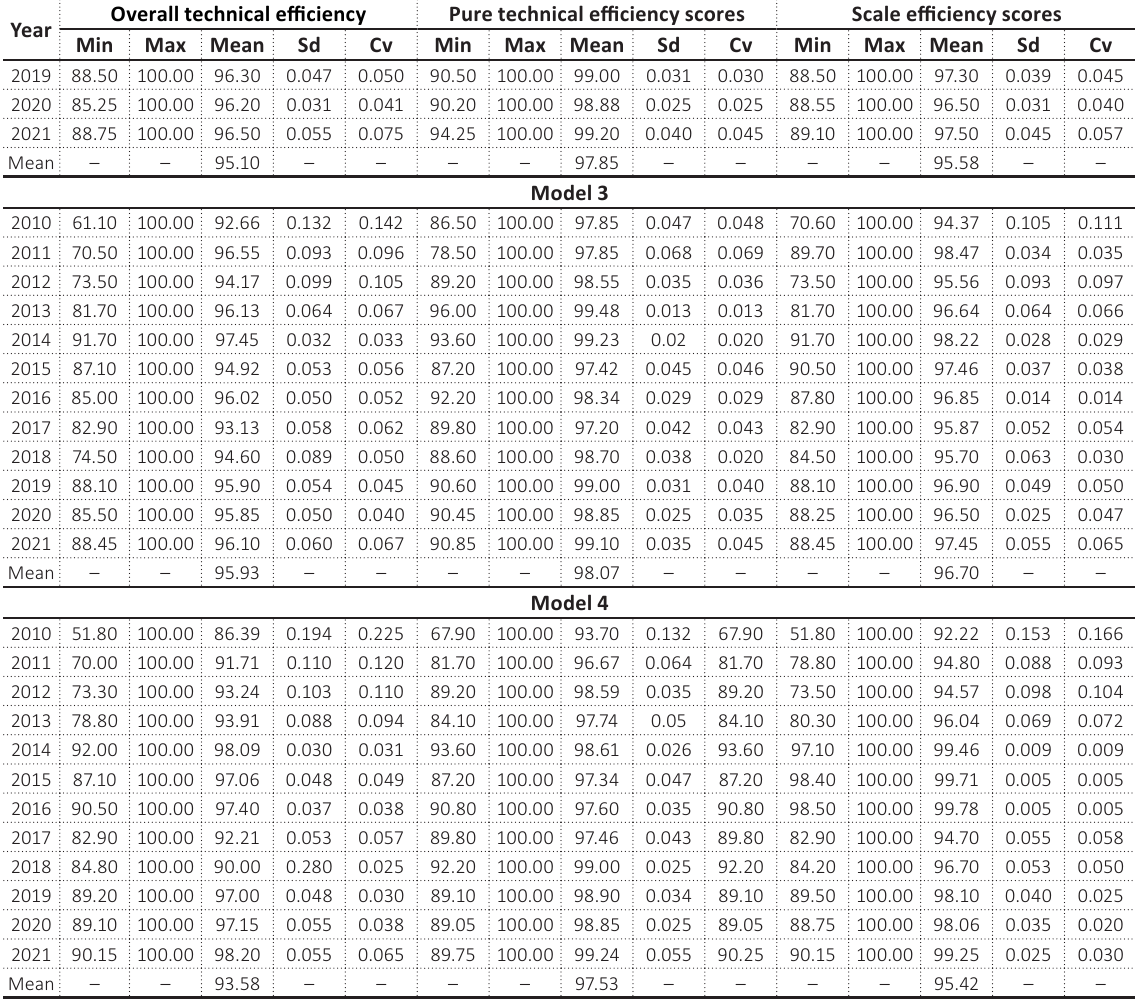
Table 3 (cont.). Descriptive statistics of annual efficiency score of